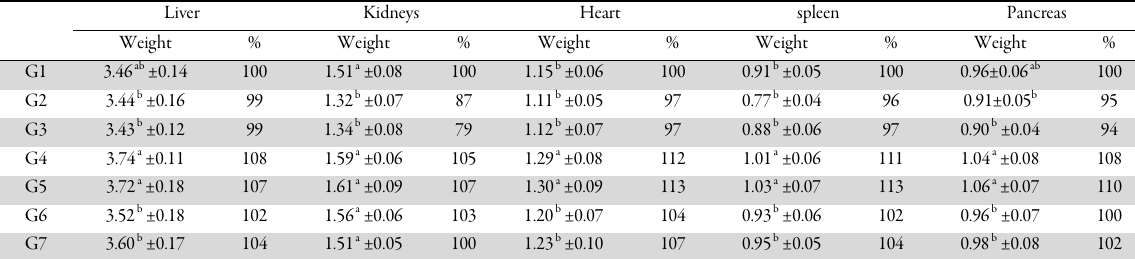
Table 3. Organs weight rates relative to the final weight of healthy young groups treated by colors wheat biscuits